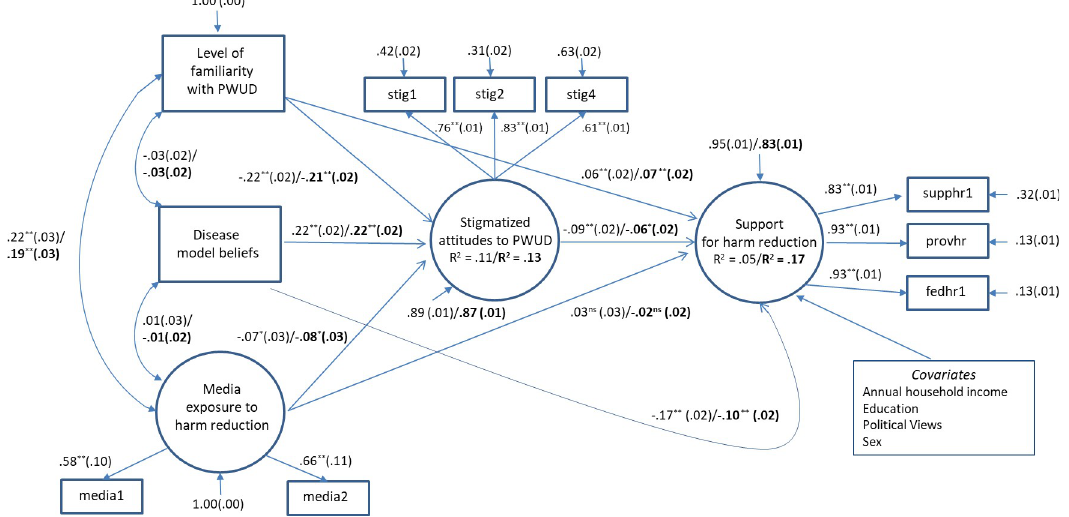
Fig 3. Final measurement and full structural model. Values are standardized coefficients ( β ) while the values in brackets are their corresbonding standard errors (SE); � p < .05; �� p < .001; Unadjusted Model Fit (RMSEA = 0.022; CFI = 0.984; SRMSR = 0.015; χ 2 = 85.937; p < 0.001, df = 26; N = 4645) / Adjusted Model Fit (RMSEA = 0.028; CFI = 0.968; SRMSR = 0.017; χ 2 = 211.227; p < 0.001; df = 46; N = 4645).